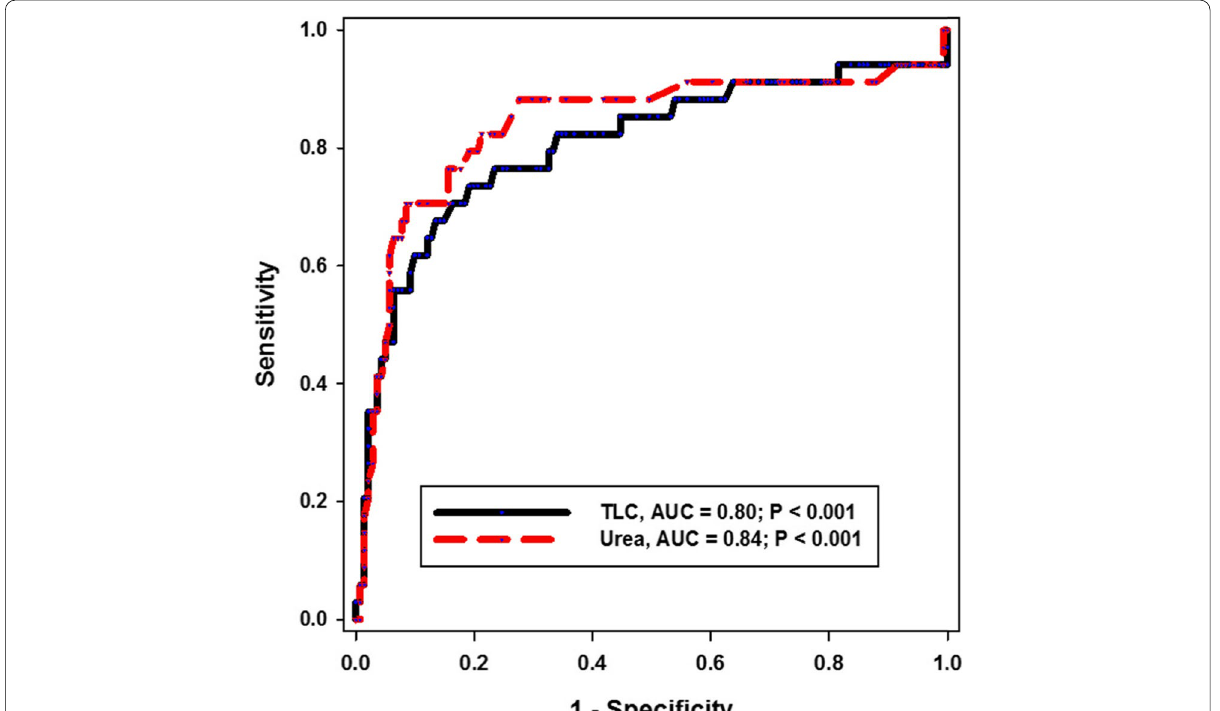
Fig. 2 Receiver operating curve for the sensitivity and specificity of TLC and urea in predicting the in‑hospital mortality of COVID‑19 pneumonia. TLC, total leukocytic count; AUC, area under the